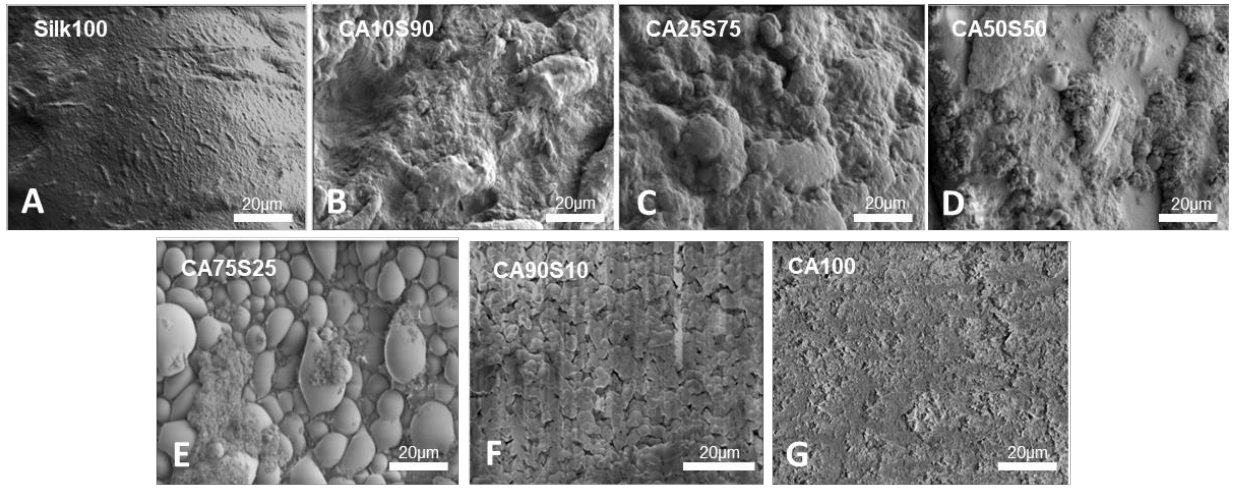
Figure 2. Scanning electron microscope (SEM) images of methanol treated composite samples of silk and cellulose acetate and their respective pure samples. ( A ) Silk 100, ( B ) CA10S90, ( C ) CA25S75, ( D ) CA50S50, ( E ) CA75S25, ( F ) CA90S10, ( G ) CA100.